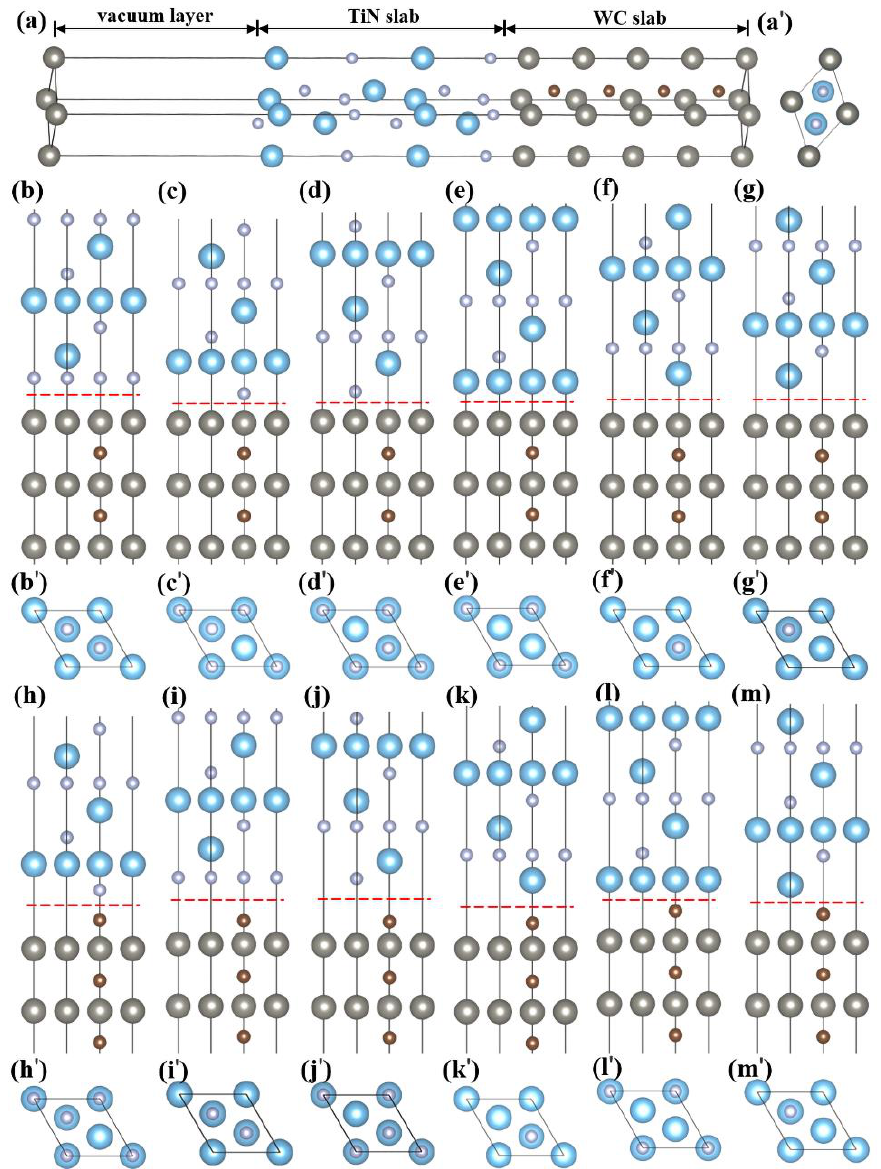
Figure 8. Interface models. ( a ) Complete computational model of the WC(0001)/TiN(111), ( a’ ) side view of model ( a ), ( b ) W-OT-N, ( c ) W-HCP-N, ( d ) W-Hole-N, ( e ) W-OT-Ti, ( f ) W-HCP-Ti, ( g ) W-Hole-Ti, ( h ) C-OT-N, ( i ) C-HCP-N, ( j ) C-Hole-N, ( k ) C-OT-Ti, ( l ) C-HCP-Ti, ( m ) C-Hole-Ti, and ( b’ ~ m’ ) top views of the interface models, respectively.